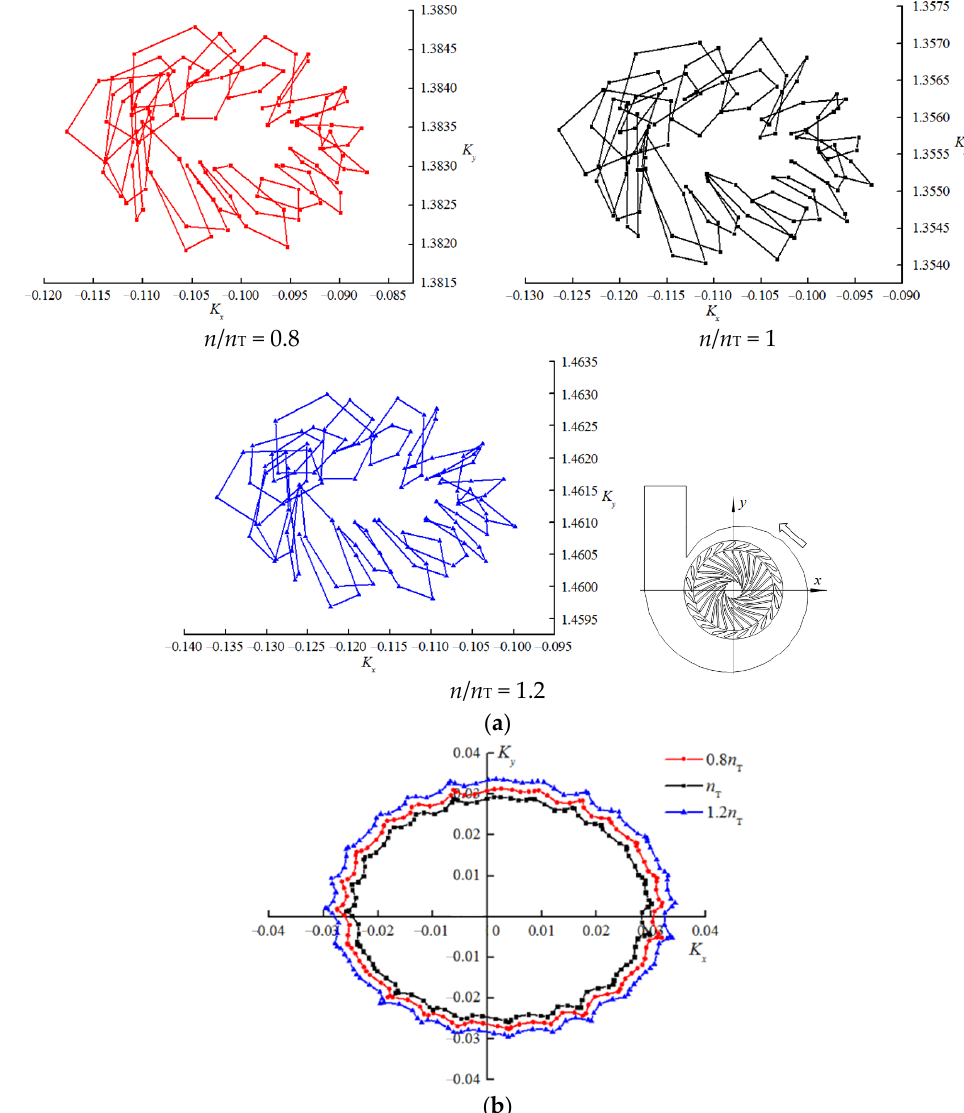
blades including 15 main blades and 15 splitter blades. The frequencies of 15 f R and 30 f R Figure 9. Radial hydraulic forces in one full working cycle. ( a ) Volute. ( b ) Impeller. Figure 9. Radial hydraulic forces in one full working cycle. ( a ) Volute. ( b ) Impeller. are named “impeller blade passing frequency”.